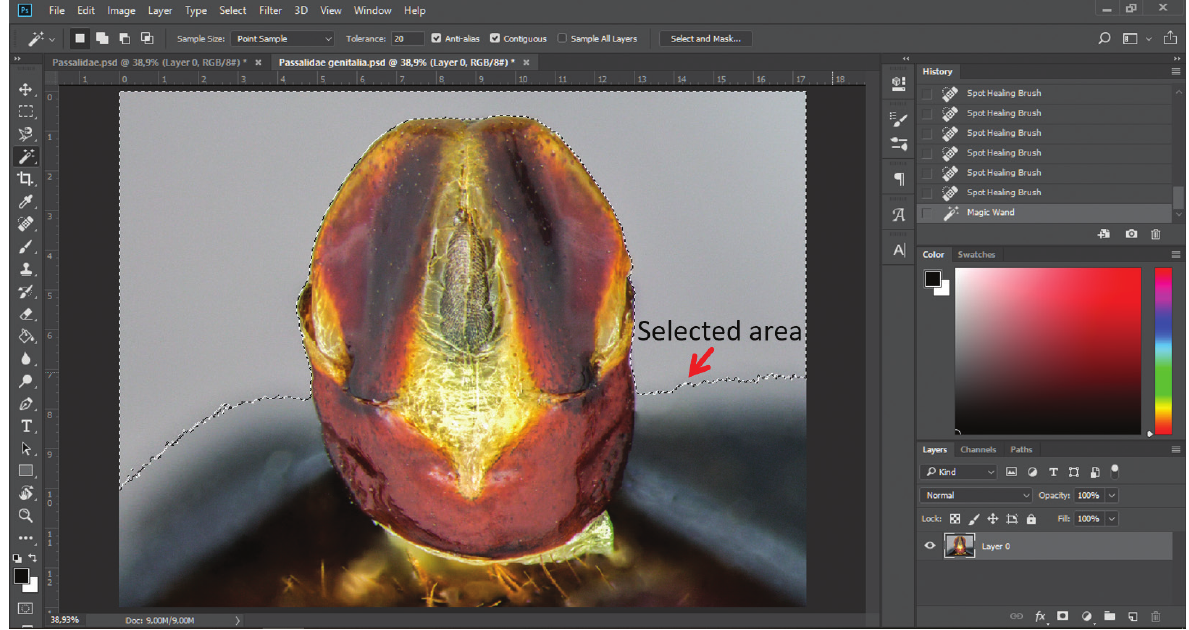
Figure 13. Most homogeneous area that can be selected using the Magic Wand